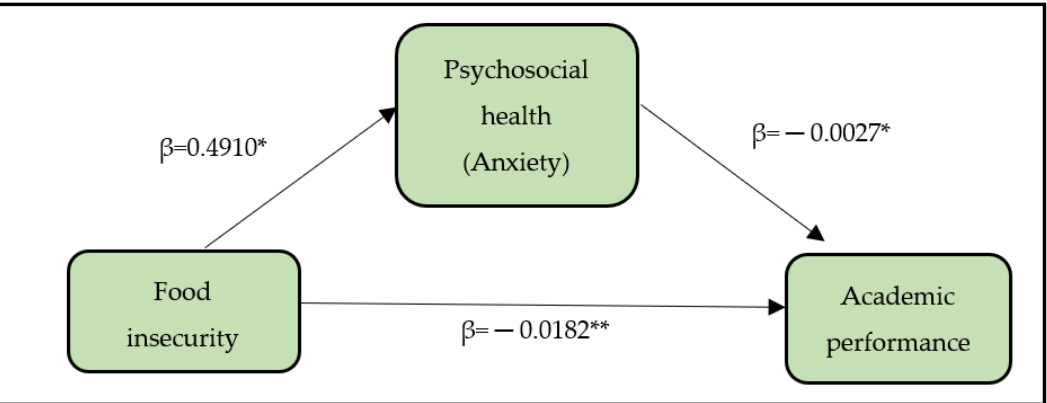
Figure 1. Framework for simple mediation (anxiety as mediator). * p -value < 0.05, ** p -value < 0.001.